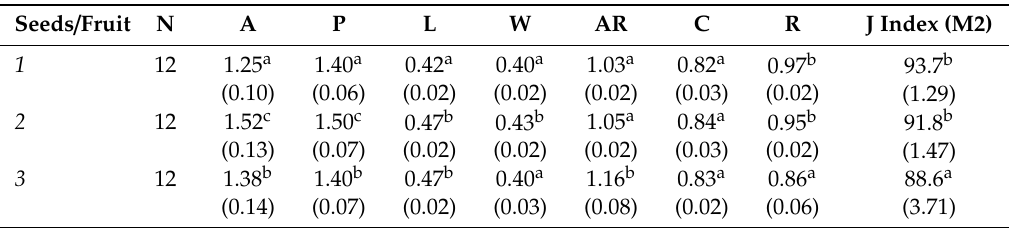
Table 6. Mean values of the area (A), perimeter (P), length of the major axis (L), length of the minor axis , aspect ratio (AR is the ratio L / W), circularity (C) and roundness (R) and J index values in seeds of P. tricuspidata (Siebold and Zucc.) Planch has one, two or three seeds per fruit. J index values were obtained with M4 (an elongated water